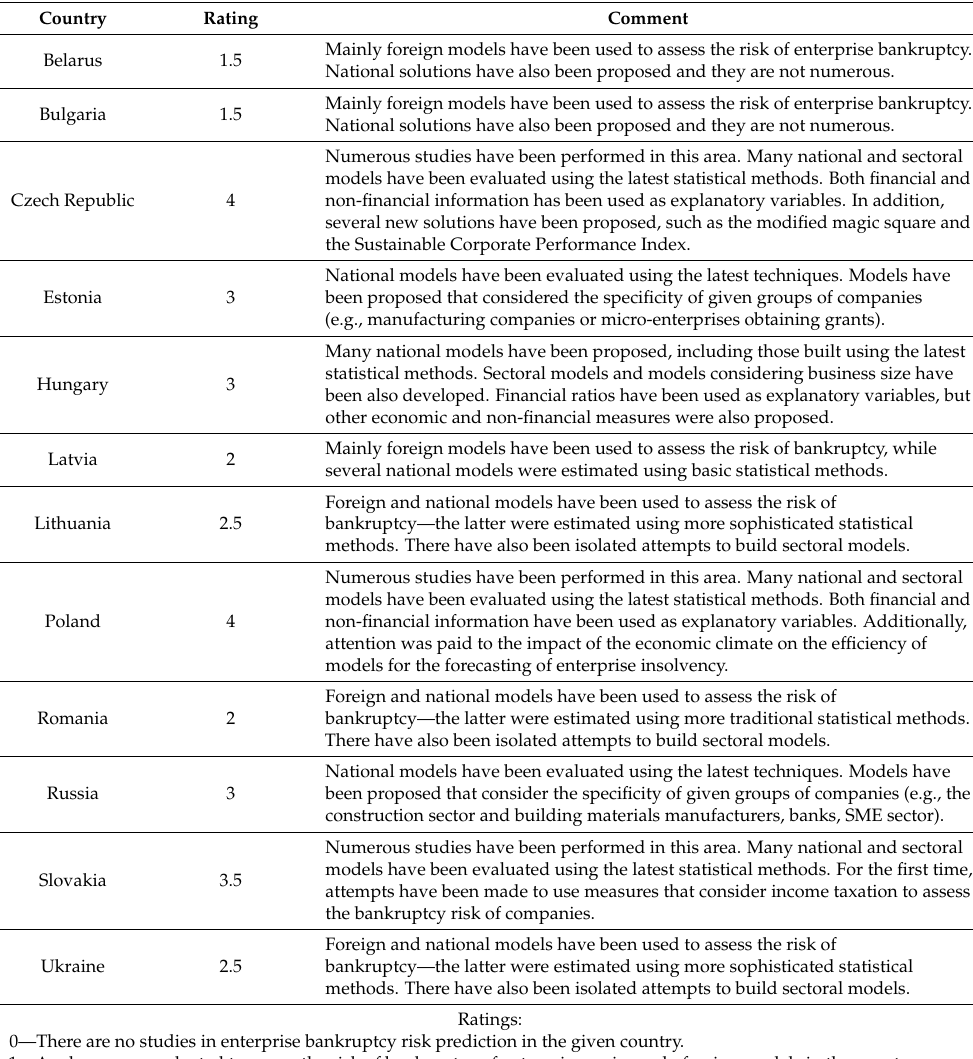
Table 2. Comparative analysis of the level of advancement of research on forecasting enterprise bankruptcy in Central and Eastern